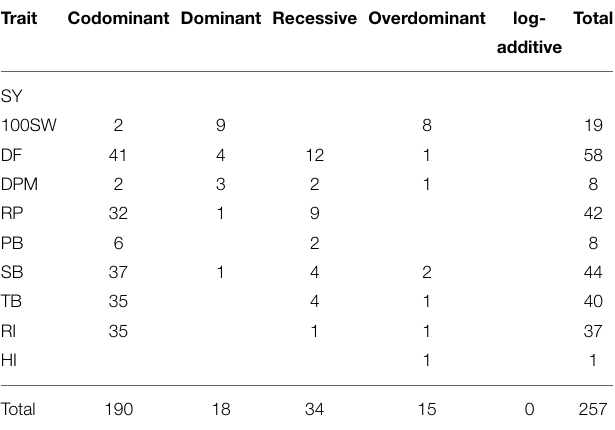
TABLE 1 | Total SNPs associated to phenotypes by genetic model testing. Trait Codominant Dominant Recessive Overdominant